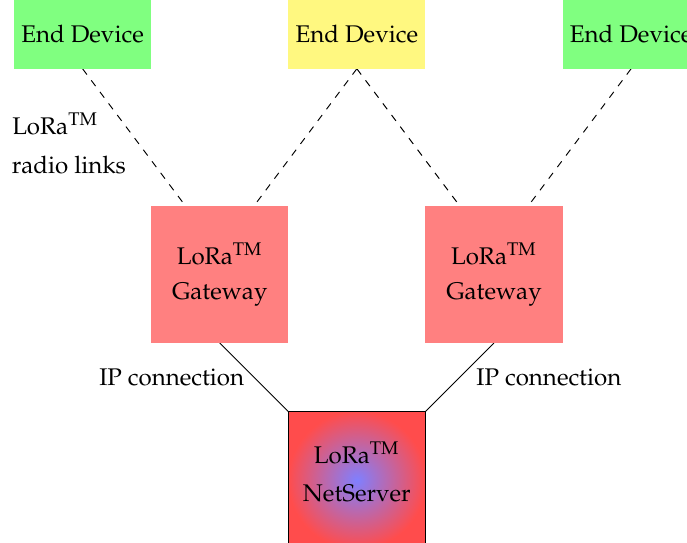
Figure 1. The architecture of a LoRaWAN TM network including the access part and back-end part. Notice that the “yellow” end device is “connected” to two distinct gateways